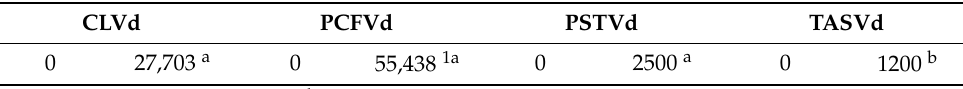
Table 4. The number of infected/raised pepper seedlings in four separate grow-out trials of commer- cially produced seeds reported in the literature and in this paper. CLVd